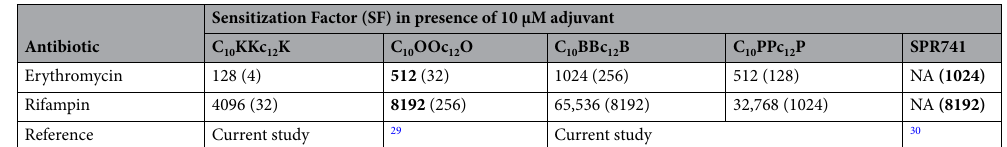
Table 1. E. coli sensitization to antibiotics by adjuvants. Values specify bacterial sensitization factors ( i.e. , fold difference between the antibiotic’s MIC in absence of adjuvant versus in its presence) to each antibiotic, as determined against E. coli 25922. SF values obtained for cyclic analogs are shown in parenthesis. Erythromycin and rifampin MIC values in absence of adjuvant were 128 and 8 µg/ml, respectively. Published data appear in bold fonts. NA¸ not